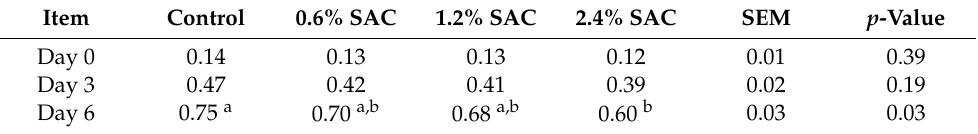
Table 12. Effects of dietary Selenium Auricularia cornea culture supplementation on oxidative stability (malondialdehyde content, nmol/mg prot) of fresh meat during simulated retail display.